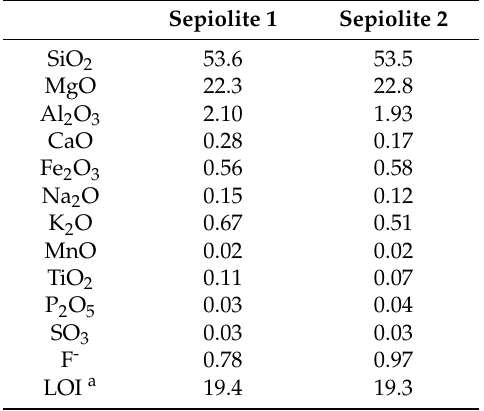
Table 1. XRF data (in wt%) of the sepiolite